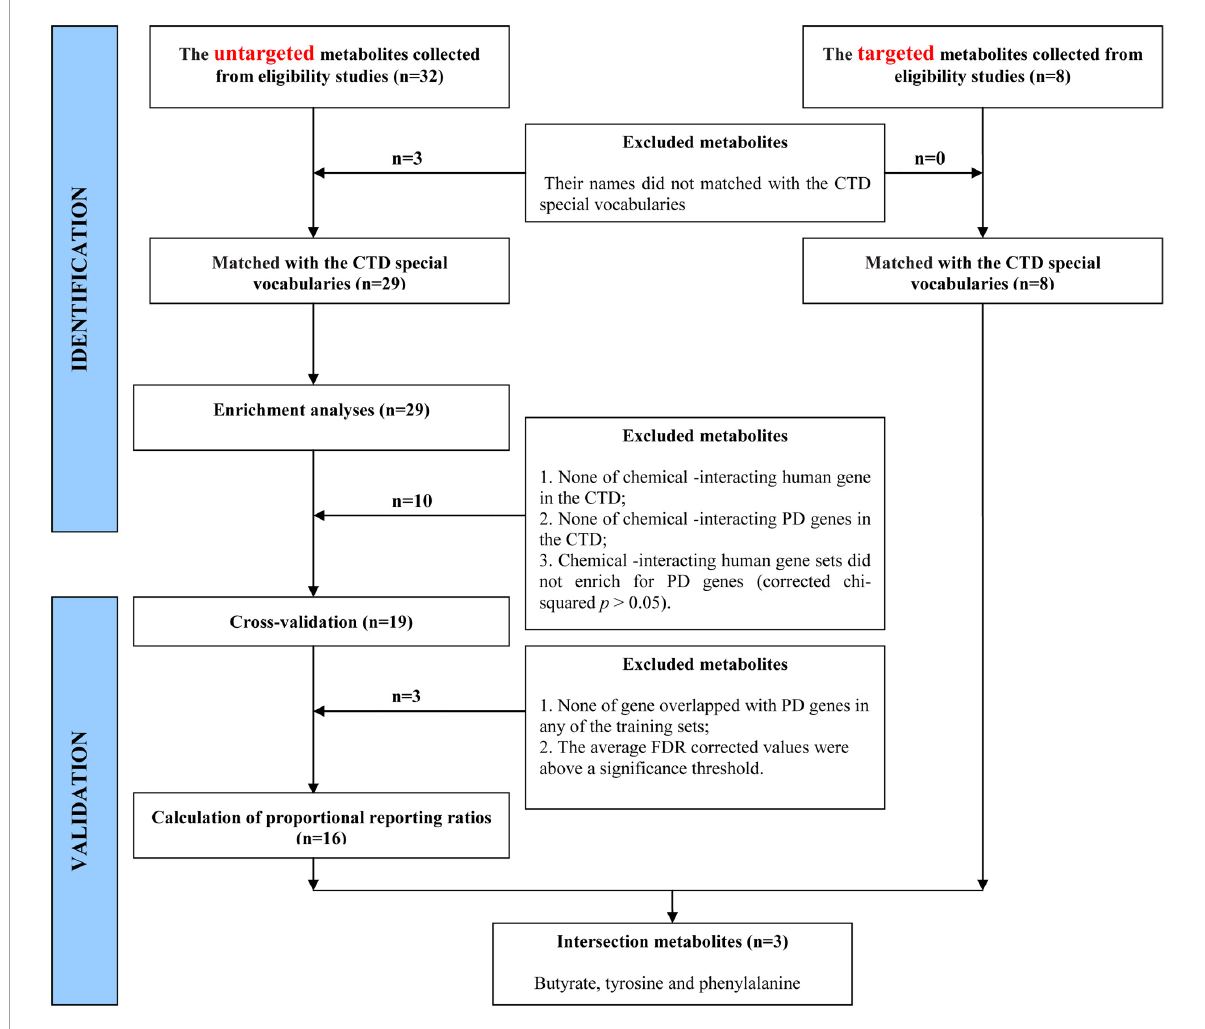
FIGURE1 The flow diagram showing metabolite identification and validation